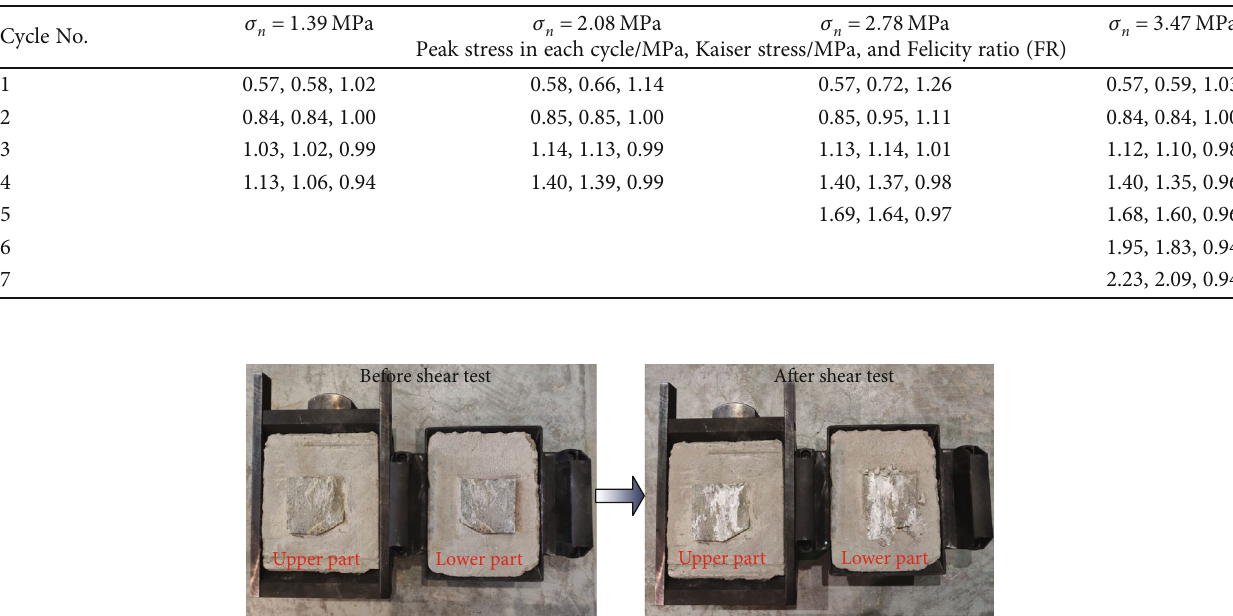
Figure 8: Felicity ratio variations under four normal stress of 1.39MPa, 2.08MPa, 2.78MPa, and 3.47MPa, respectively. Table 2: Felicity ratios under di ff erent normal stress.